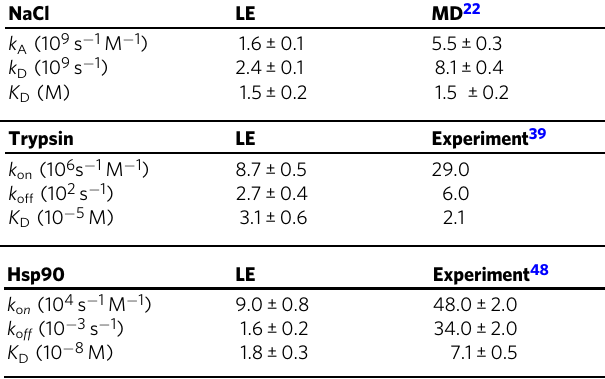
Rates resulting from fi ts in Fig. 2 (using units of molarity M, i.e., mol/l) with fi t errors as indicated 59 , and reference values from unbiased MD simulations 22 and experiment 39,48 , respectively. Dissociation constants were calculated from rate